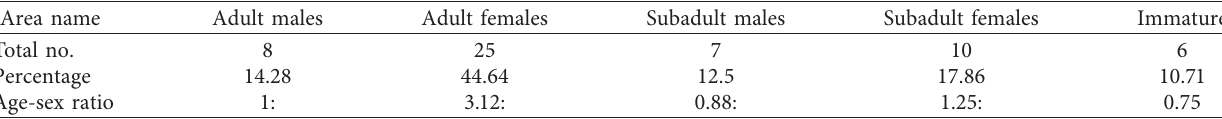
Table 2: Total number of geladas counted in Mt. Guna with respect to age and sex groups.